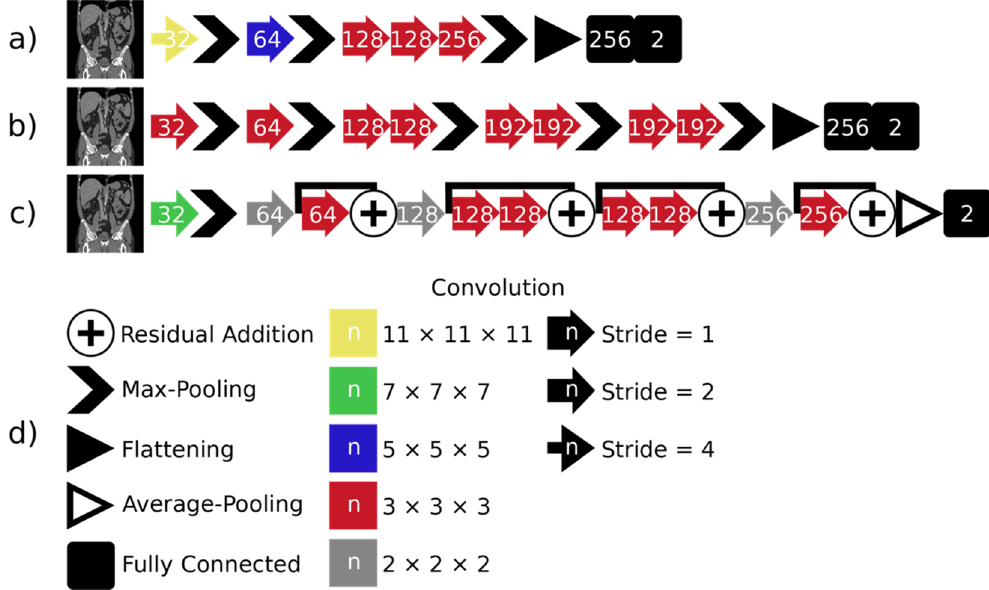
Figure 2. The three architectures used for classification are shown on the left: ( a ) 3D AlexNet, ( b ) 3D VGG and ( c ) 3D ResNet. All operations are given in the legend on the right of ( d ). The number of channels resulting from operations is marked by the number on the operation symbol.